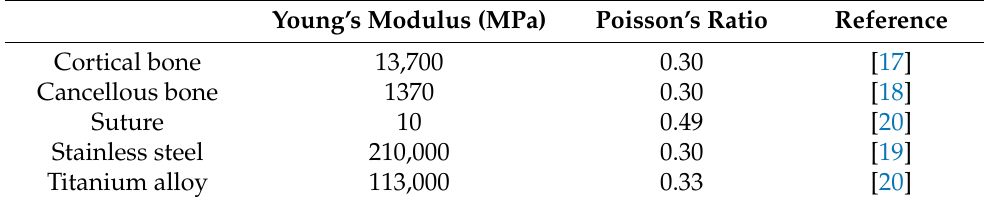
Figure 3. Four insertion types of miniscrews with varying lengths. ( a ) Monocortical: posterior and anterior miniscrews 6 mm in length both sides; ( b ) monocortical deepening: posterior and anterior miniscrews 8 mm in length both sides; ( c ) bicortical: posterior and anterior miniscrews 10 mm and 12 mm in length both sides; ( d ) bicortical deepening: posterior and anterior miniscrews 14 mm and 16 mm in length both sides. Table 1. Mechanical properties of the materials assigned in